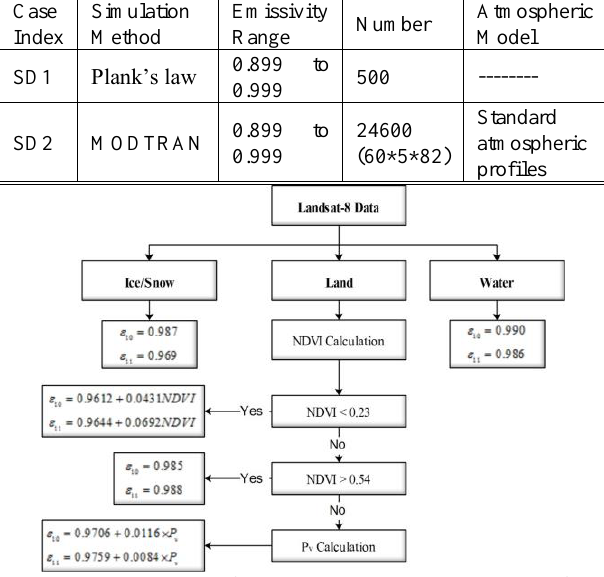
Table II - Simulated datasets